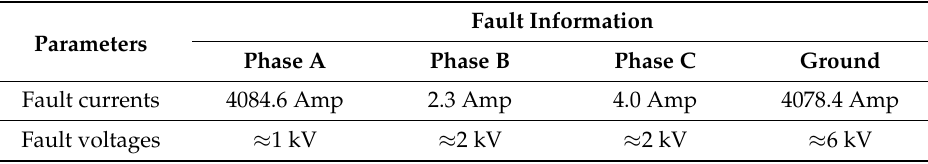
Table 11. Fault information with respect to a SPGF at F1 (a location on the 473 Go Noi